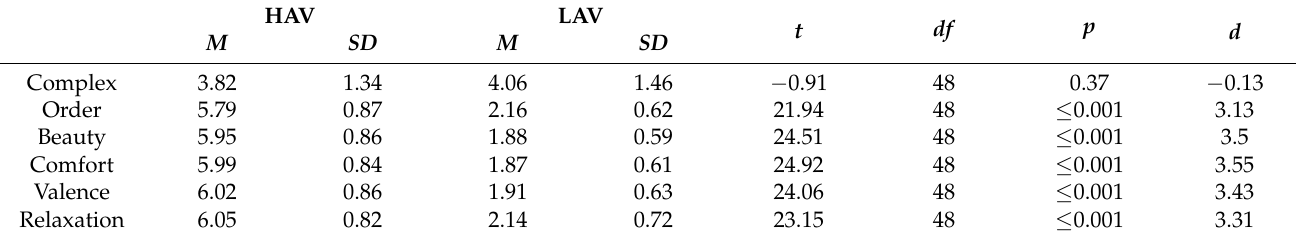
Table 2. Material evaluation of the aesthetic value